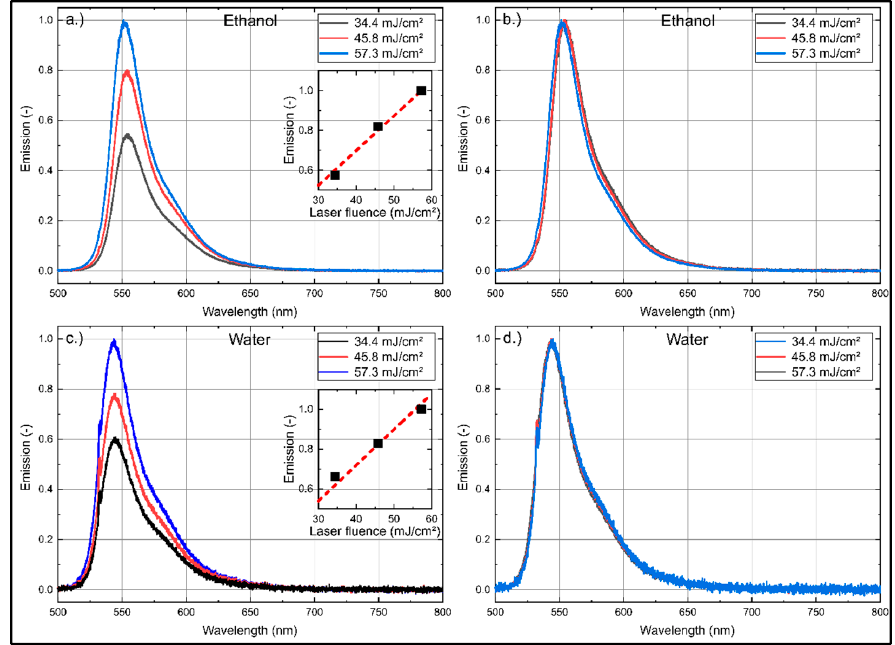
Figure 7. Emission spectra (left normalized to the respective maximum intensity; right: normalized intensity) of Eosin-Y dissolved in ethanol ( a , b ) and water ( c , d ), inserted diagrams show linearity ( R 2 = 0.999) of the integral LIF-signal for various laser fluences; 293 K, 0.1 MPa.